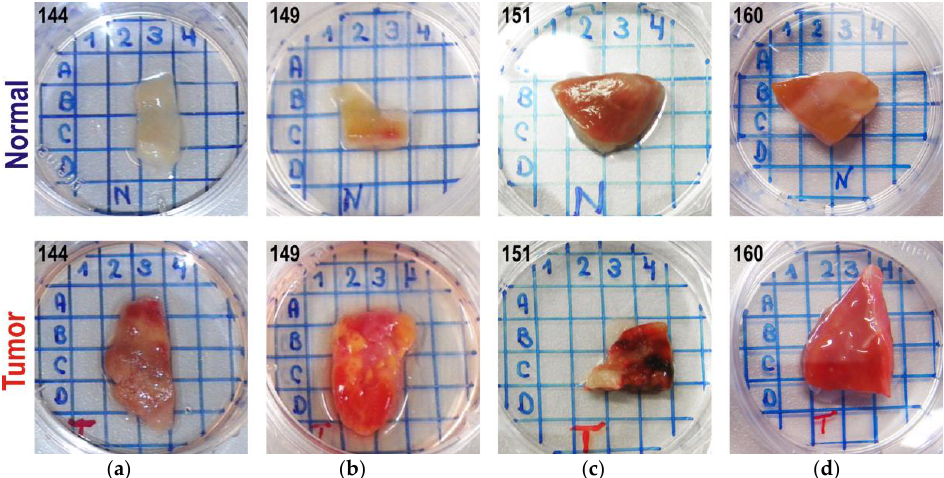
Figure 2. Renal biopsies of patients in Series B measurements: ( a ) 144, ( b ) 149, ( c ) 151, and ( d ) 160. Healthy and tumor tissues are marked as “N” and “T”, respectively. The grid period is 0.5 cm. Individual data were designated by the sample type ( T and N for tumor and normal samples, respectively), the patient ID and the ordinal number of repeated spectral/sensor measurements. An